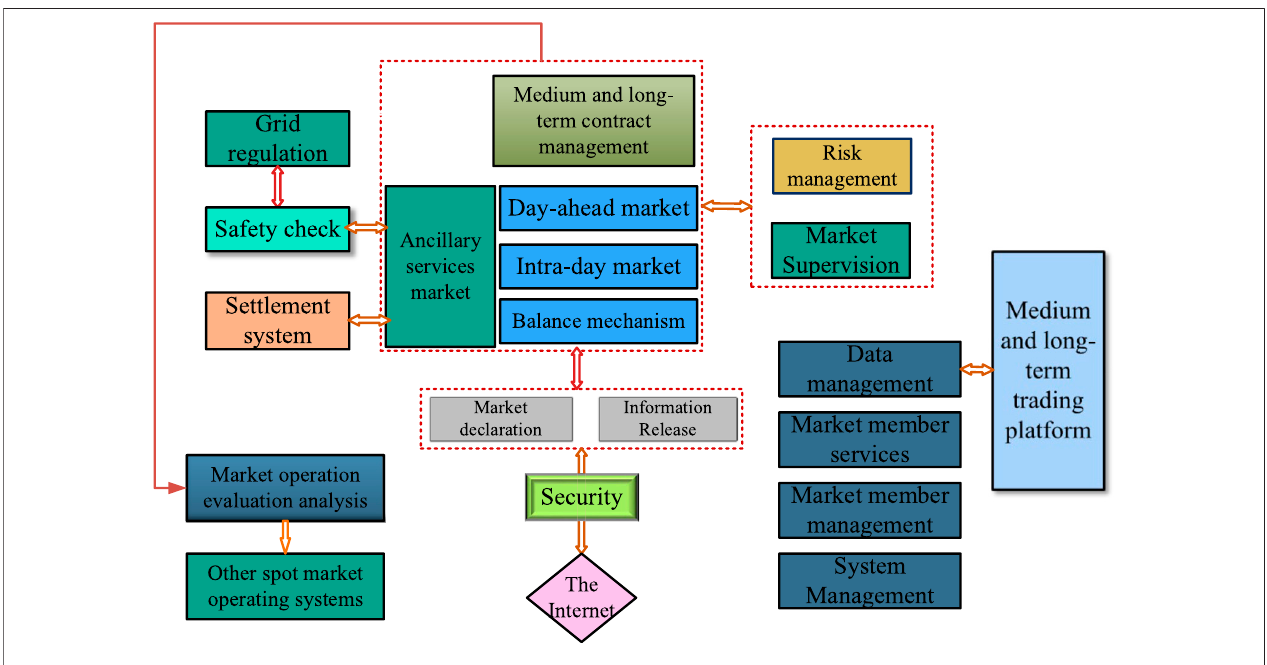
FIGURE 3 | Operating system diagram of the power spot